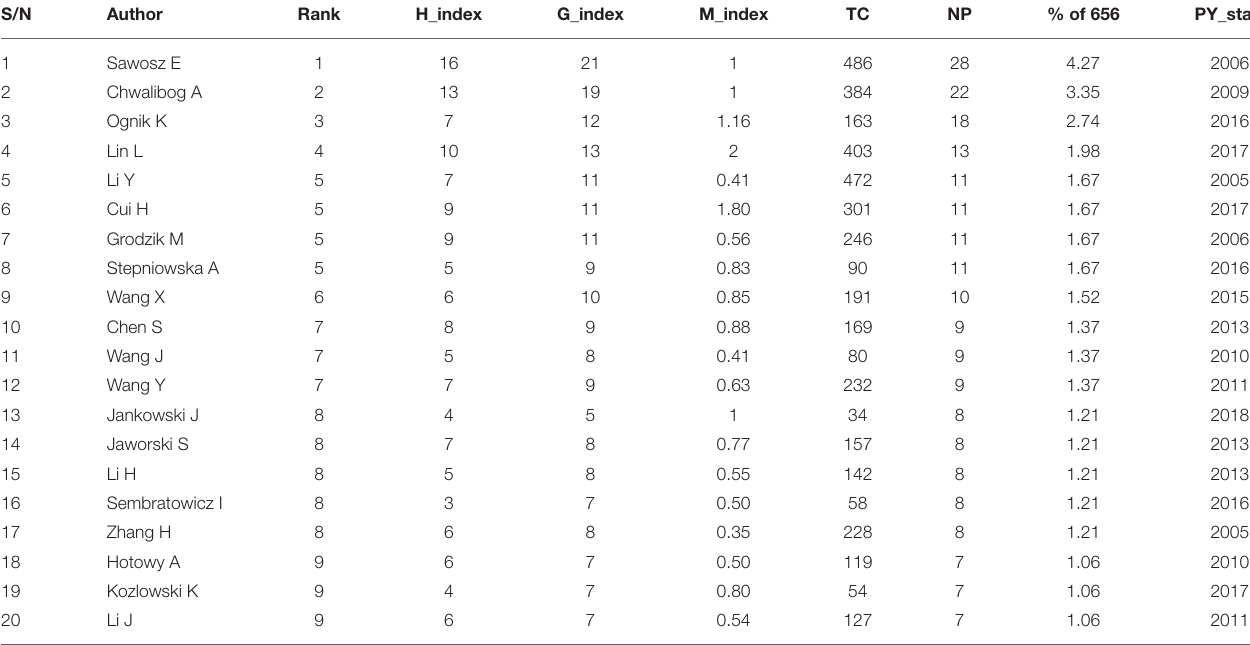
TABLE 5 | Top 20 relevant/productive authors on meat production through nanotechnology.